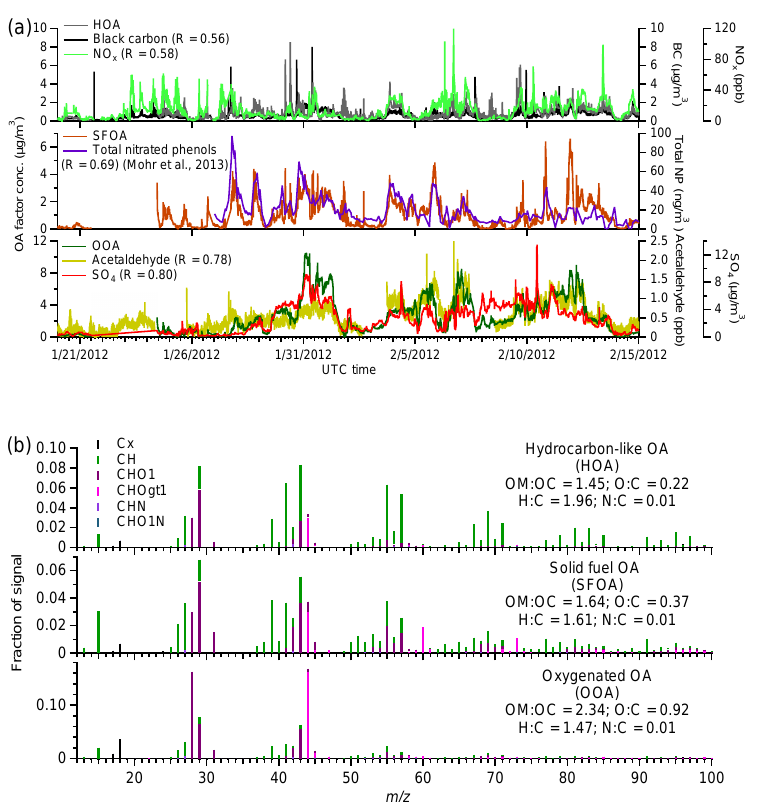
Figure 4. (a) Time series of OA factors resolved from the unconstrained PMF analysis on the ambient data (i.e., PMF ambient ) and corre- sponding external tracers. (b) Mass spectra of OA factors, which are colored by the ion type. The time series of total nitrated phenols is from Mohr et al.